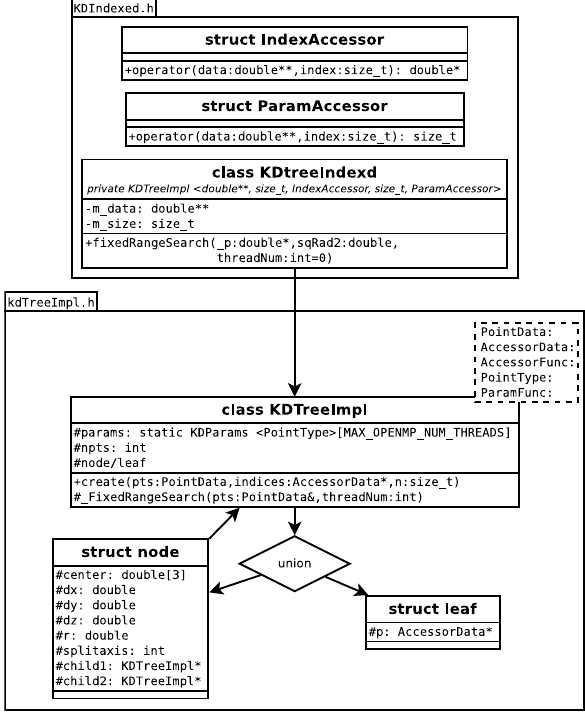
Figure 2: Boxes are in UML, relationships (arrows) are not. KDTreeImpl is templated by KDtreeIndexed with the param- eters listed in the comment. The node and leaf structure are a C++ union . The params member of KDTreeImpl is static. UML packages are used to indicate file membership and to group for readability. Only the fixedRangeSearch search function and its recursive counterpart FixedRangeSearch are listed for